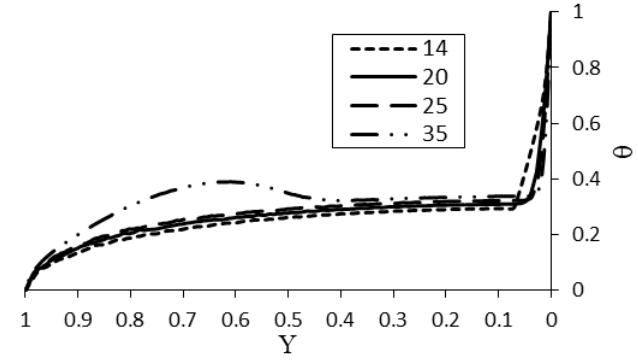
Fig. 9. Air temperature at midlength (X=0.5L) of different